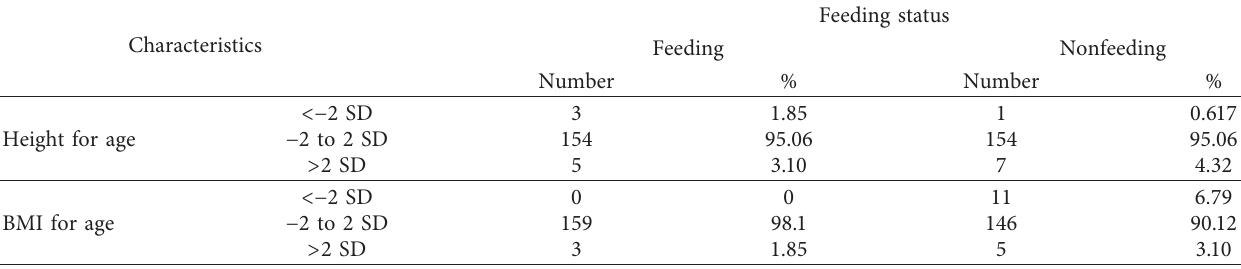
Table 3: Nutritional status of participants at selected primary schools in Yeka subcity, Addis Ababa, Ethiopia, August 2018 ( n � 162 for each).